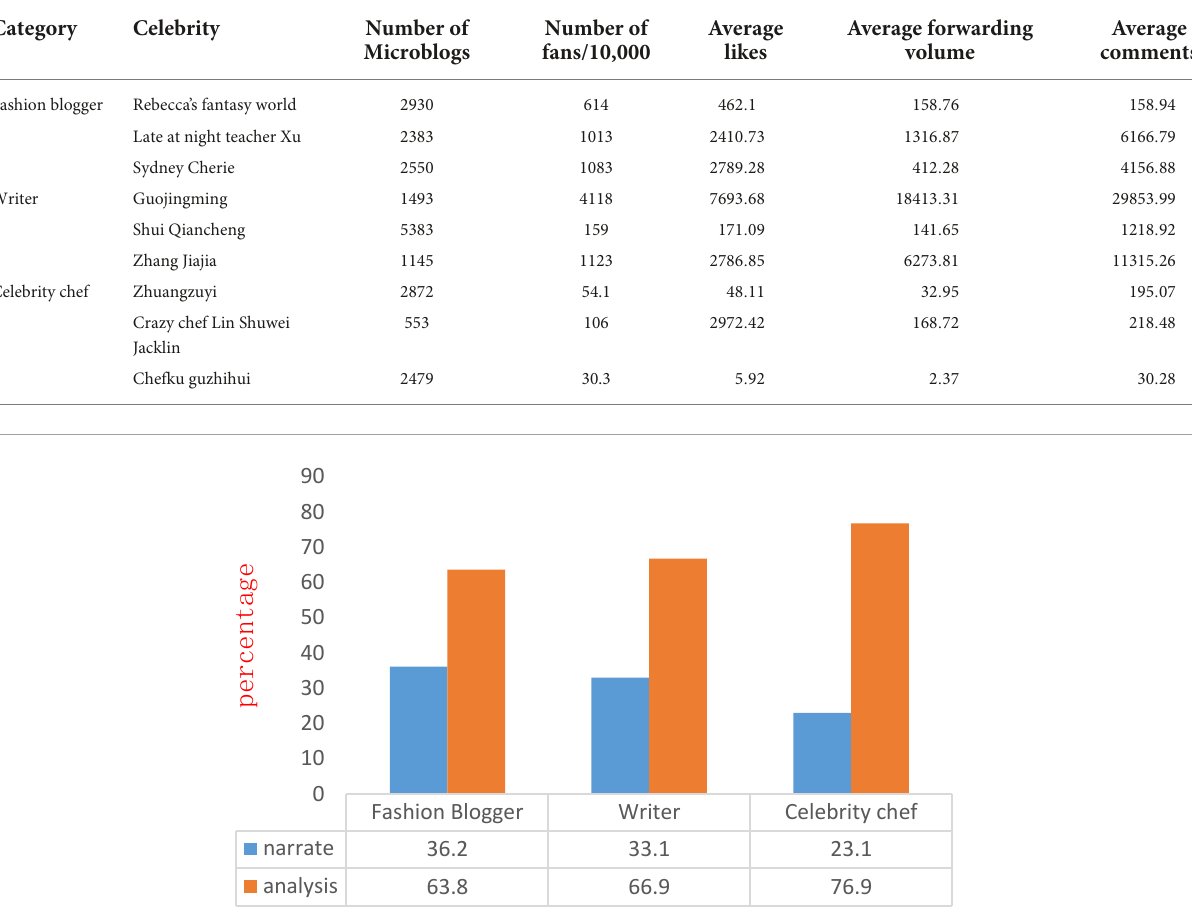
TABLE 1 Descriptive statistics of celebrity Microblog data.